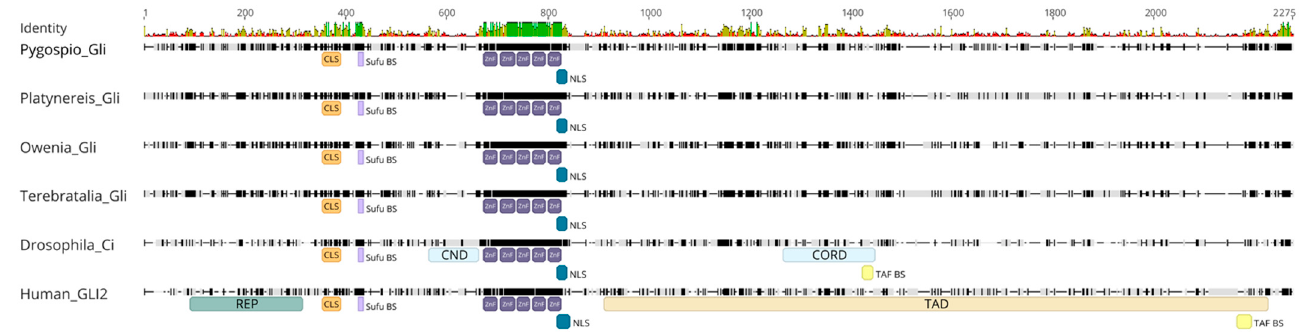
Figure 9. Multiple sequence alignment of Gli proteins. In the N-terminal regions of Pele-Gli and Pdum-Gli, we found a ciliary localization signal and Sufu-binding site. Both domains have previously been identified in mammalian GLIs and Ci and seem to be conserved among Metazoa [93,94]. Pele-Gli and Pdum-Gli also contain a bipartite nuclear localization signal in their Zn-finger DNA-binding domains. Ci, Cubitus interruptus; GLI, glioma-associated oncogene homolog; ZnF, zinc-finger DNA-binding domain; CLS, ciliary localization signal; Sufu BS, Sufu-binding site; NLS, nuclear localization signal; Rep, repressor domain; TAD, transcription activation domain; TAF BS, TAF-binding site; CDN, CORD, Cos2-binding sites.